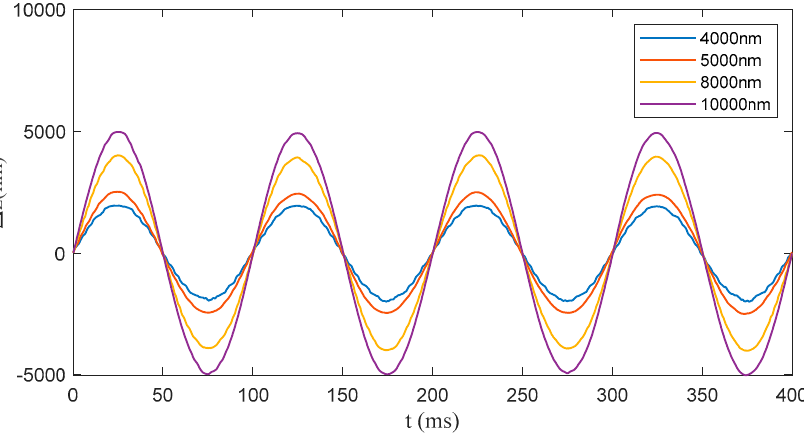
Figure 8. Reconstructed results of the sinusoidal motion of grating only in the Z -direction with am-